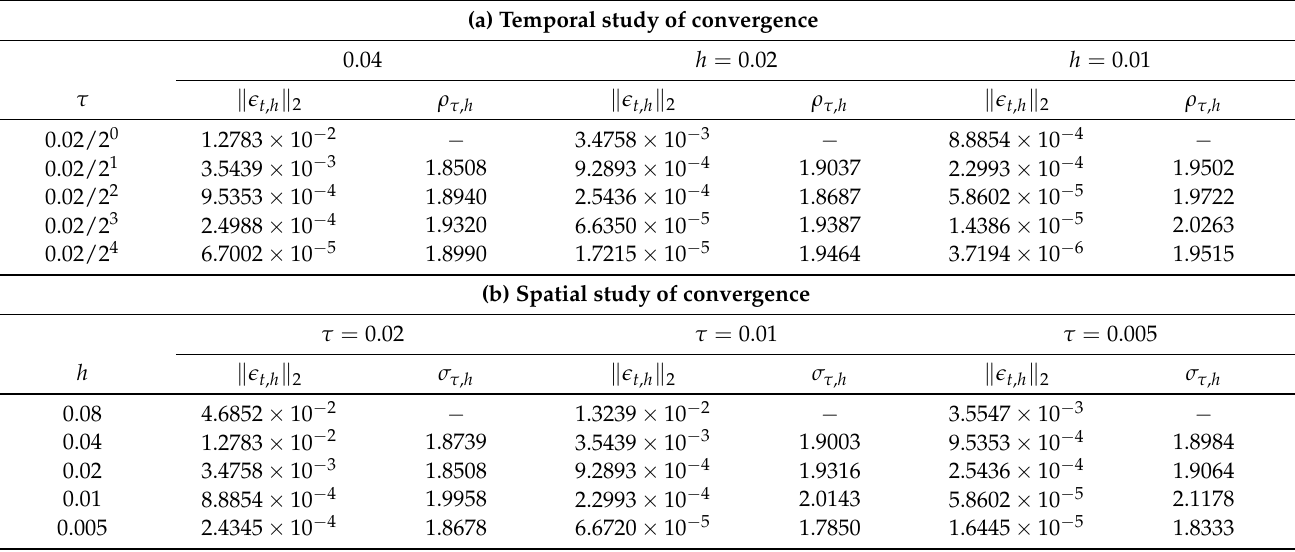
Table 2. Table of absolute errors in the Euclidean norm and (a) temporal and (b) spatial rates of convergence for various values of the parameters τ and h . The experiment corresponds to that described in Example 2. (a) Temporal study of convergence